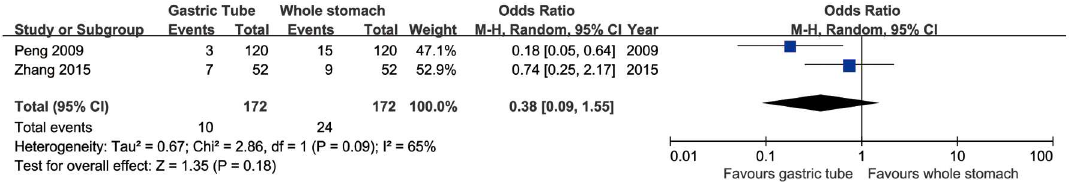
Fig 5. Forest plot of pneumonia in the whole-stomach and gastric-tube groups.